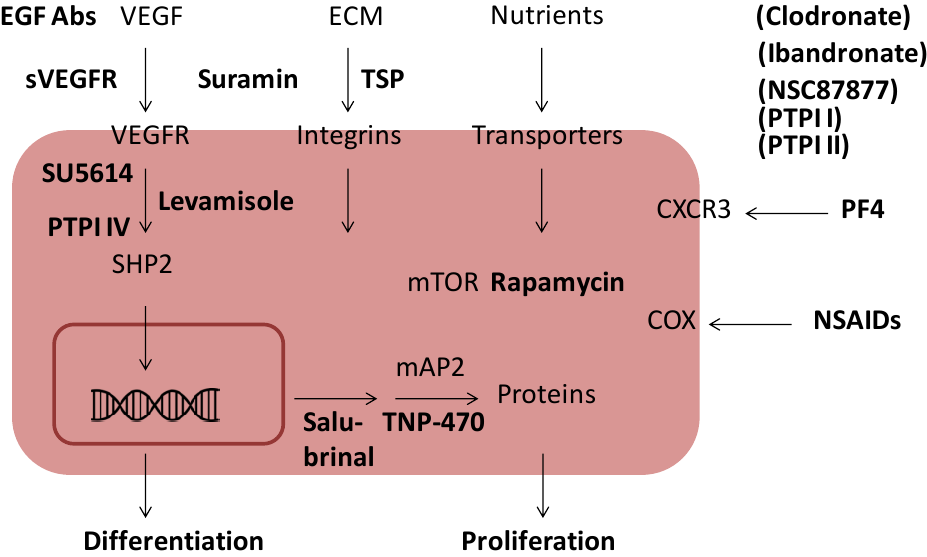
Figure 6. Schematic presentation of the influence of angiogenesis inhibitors on EC signaling. Important signaling pathways in ECs are the VEGF pathway, the ECM integrin pathway and the mTOR pathway. Blocking of the VEGF pathway by VEGF antibodies, SU5614, levamisole or PTPI IV inhibits differentiation. Blocking of ECM integrin signaling by TSP or mTOR signaling by rapamycin inhibits proliferation as does salubrinal and TNP-470. PF4, suramin, NSAIDs, clodronate, NSC87877, PTPI I, PTPI II inhibit EC proliferation in a morphologically similar way, while ibandronate gives mixed morphology, but the exact relationships between these with the major signaling pathways are